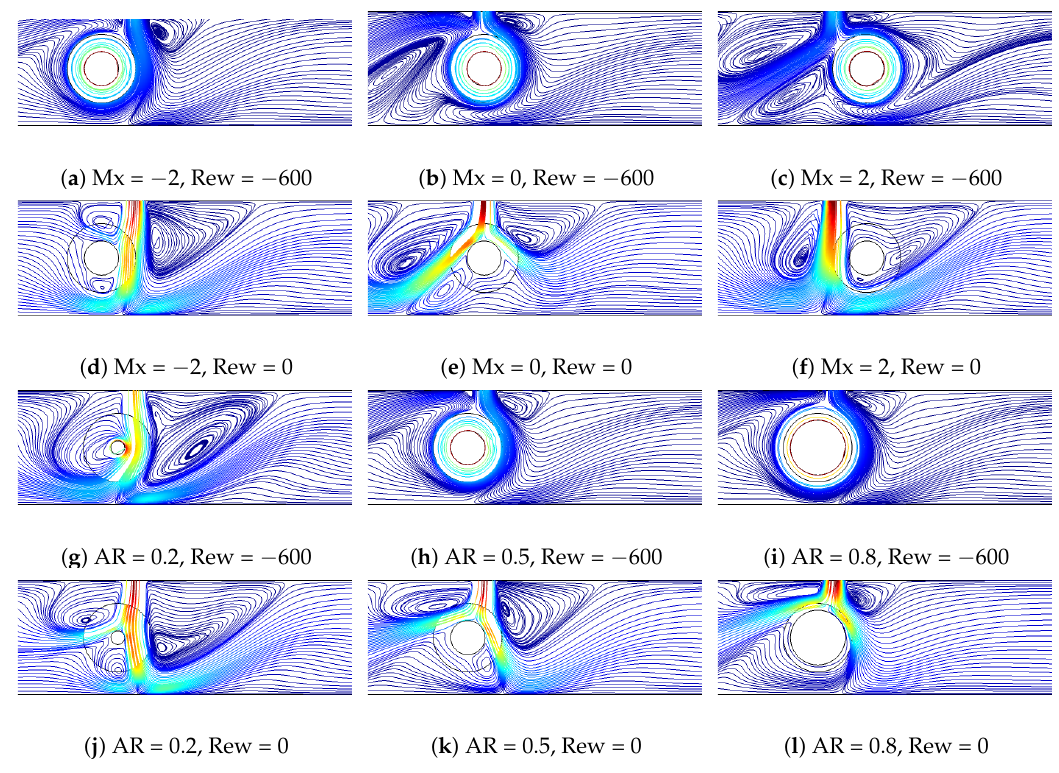
Figure 11. Effects of the location (AR = 0.5, a – f ) and aspect ratio (Mx = − 1, g – l ) of the porous object on the variation in streamlines at two Rew values (Ha = 10,Da = 5 × 10 − 2 ).